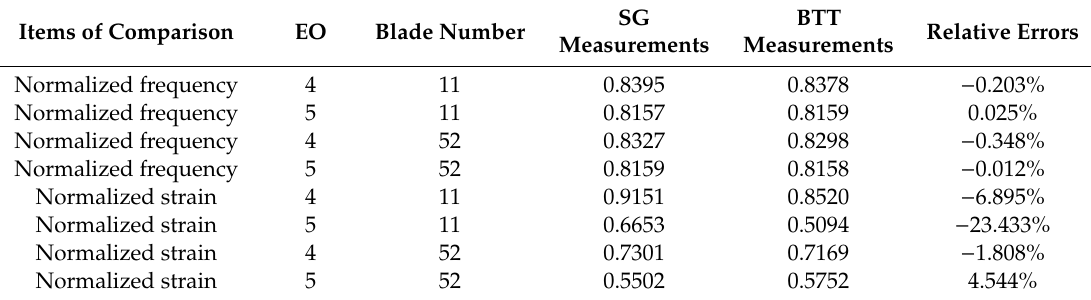
Table 1. Comparison results of blade tip timing (BTT) measurements with SG measurements. Items of